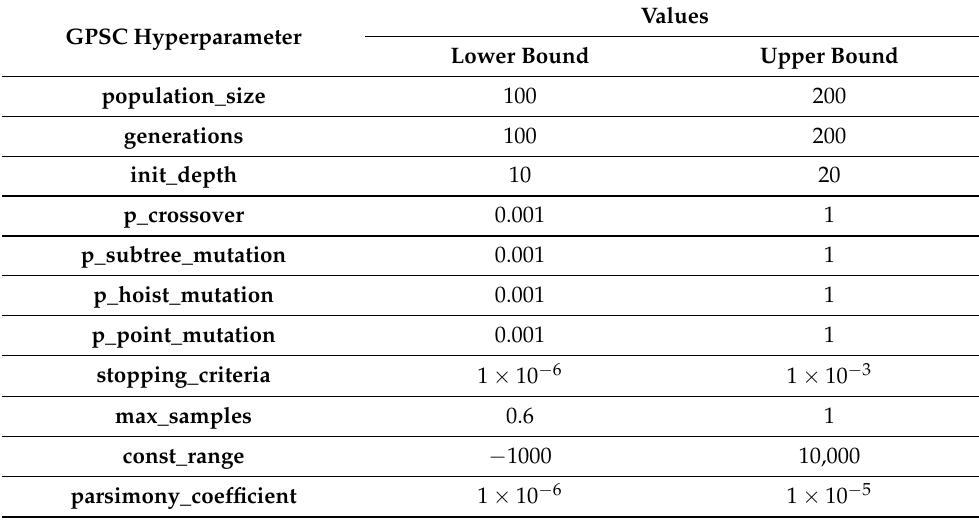
Table 7. The list of all GP Symbolic Classifier hyperparameters with predefined range used in random hyperparameter